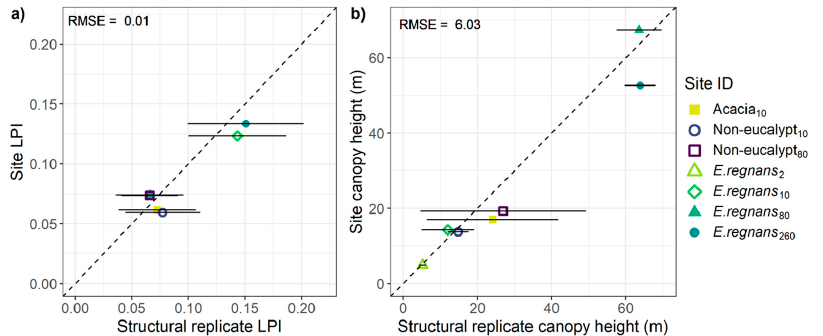
Figure 4. Structural replicate plots for ( a ) LPI 0.5m and ( b ) 95th percentile canopy height (CH 95 ). Instrumented site properties are represented on the y-axis, and structural replicate ( n > 12) properties